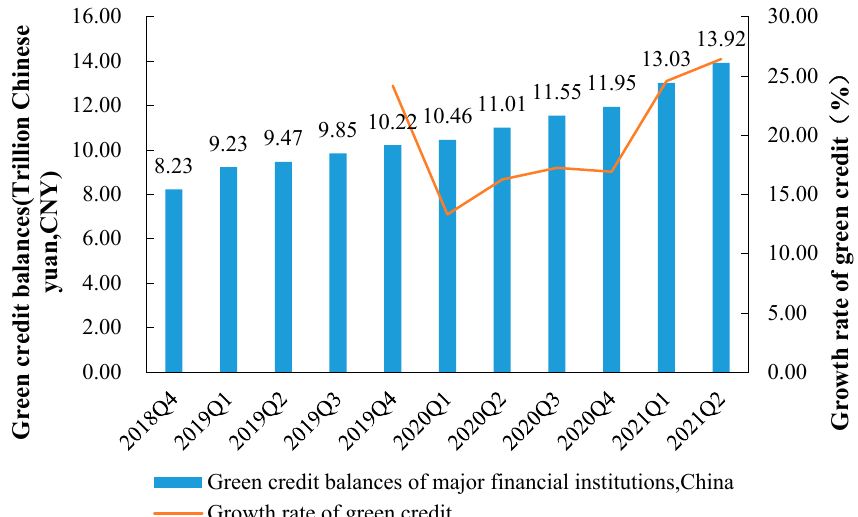
Figure 1. Size and growth rate of green credit in China, 2018–2021. Note: Data are from China Development Bank.